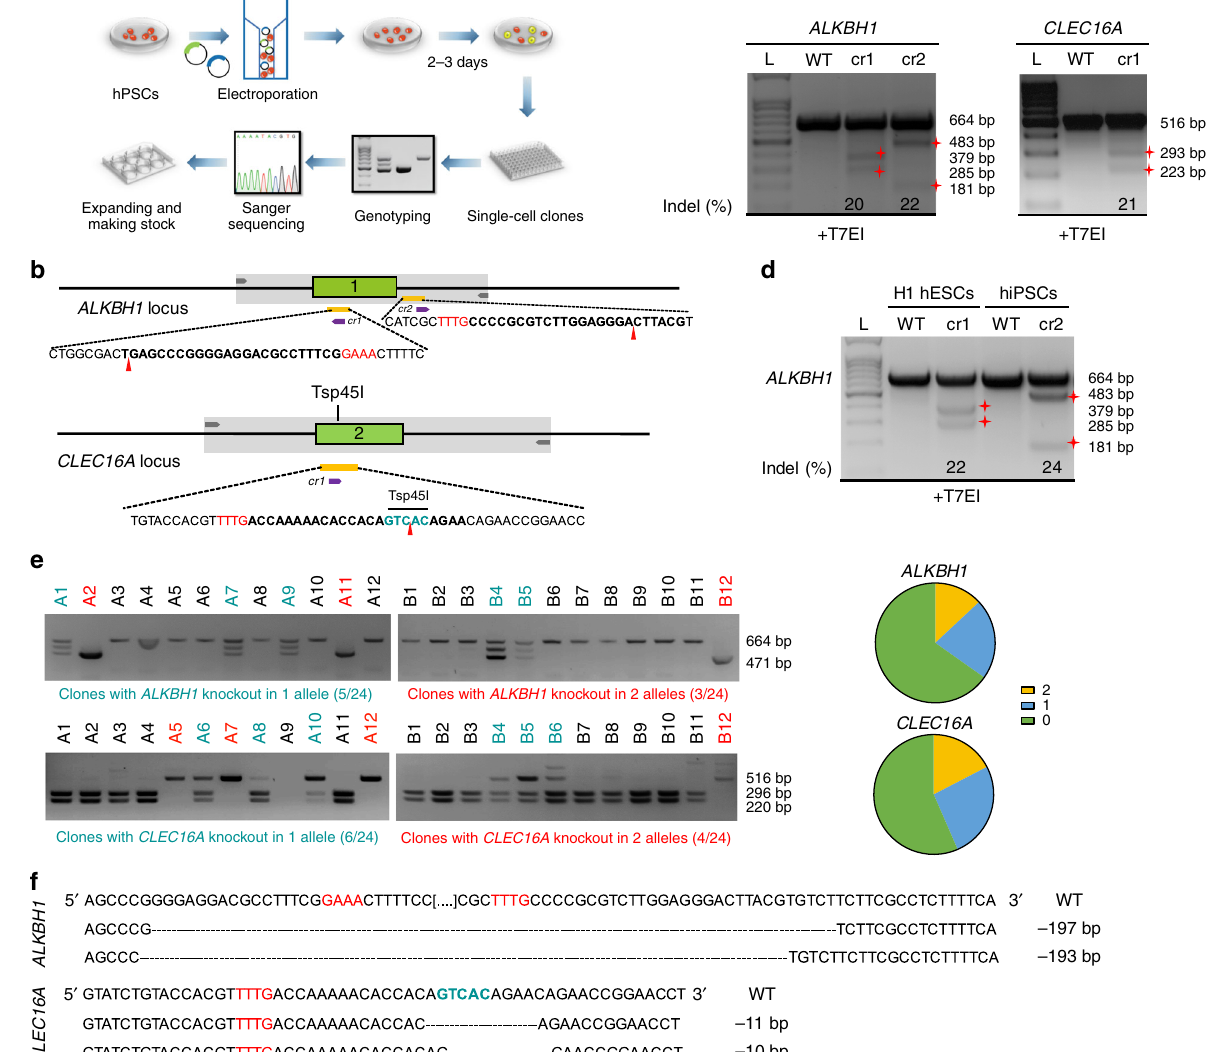
containing the speci fi c crRNA targeting OCT4 , and the knockin template containing an eGFP reporter and a puromycin- resistance cassette. After electroporation, hPSCs were seeded into 48-well plates already added with small molecules. hPSCs